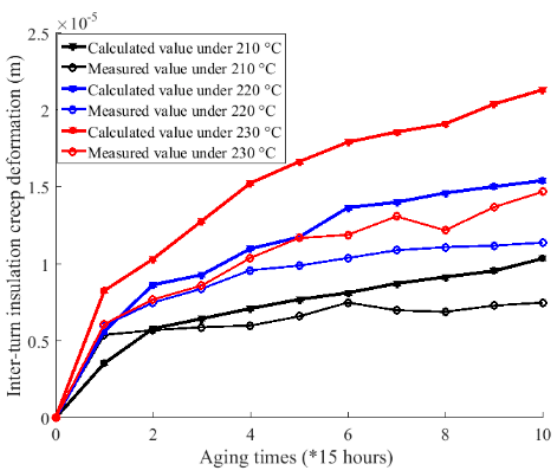
Figure 20. Comparison between calculated and measured creep deformation under 210 °C, 220 °C, and 230 °C.